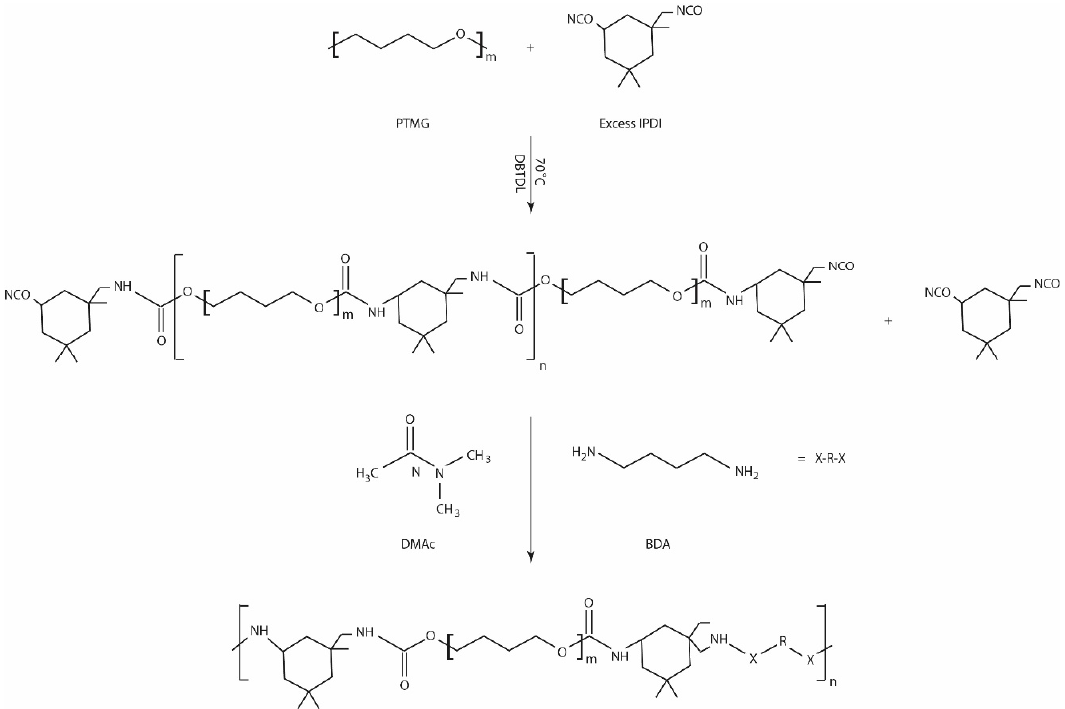
Scheme 1. Schematic illustration of polyurethane synthesis.